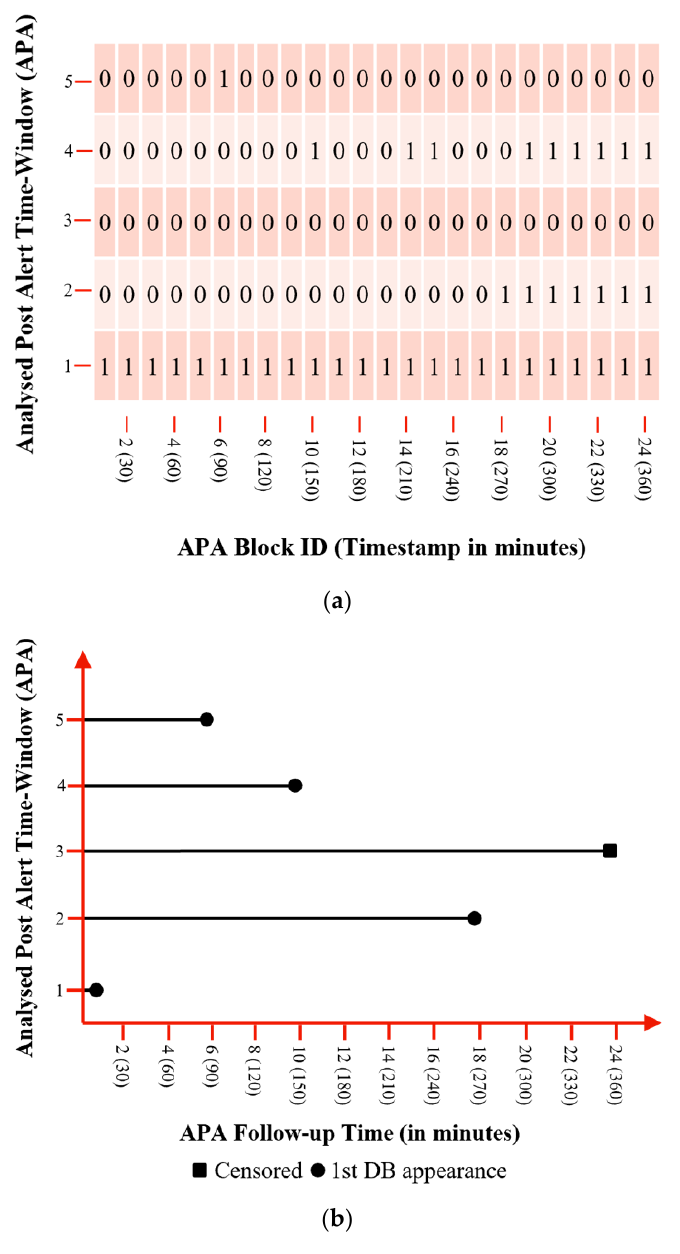
Figure 2. A schematic overview of five analysed post alert time windows (APA) covering the period of 6 h post-alert generation. ( a ) An illustration of the tabular dataset in its raw form, where 0 and 1 symbolise defective (DB) and non-defective (NDB) blocks, respectively. ( b ) An illustration of the lengths of their follow-up times, where each length corresponds to the time to occurrence of the event of interest, i.e., 1st DB block during APA. These lengths are used for the calculation of defect free and conditional defect free survival probabilities.